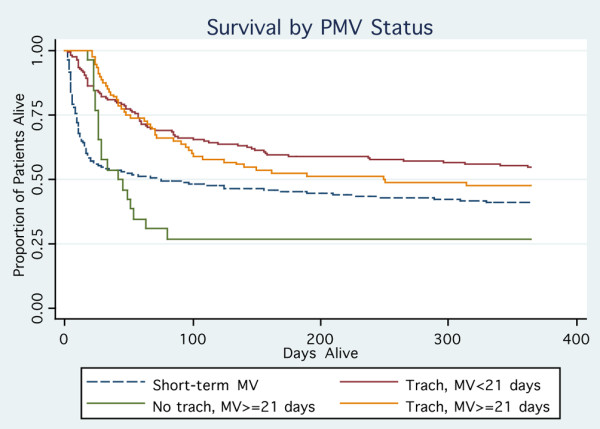
Survival among all patients by duration of ventilation and tracheostomy status. Kaplan-Meier plot demonstrating one-year survival by PMV status. The group with the best survival is those who were ventilated for < 21 days and who received a tracheostomy. Persons ventilated for at least 21 days but who did not receive a tracheostomy experienced the worst survival. Other groups had intermediate one-year survival. MV, mechanical ventilation; PMV, prolonged mechanical ventilation.